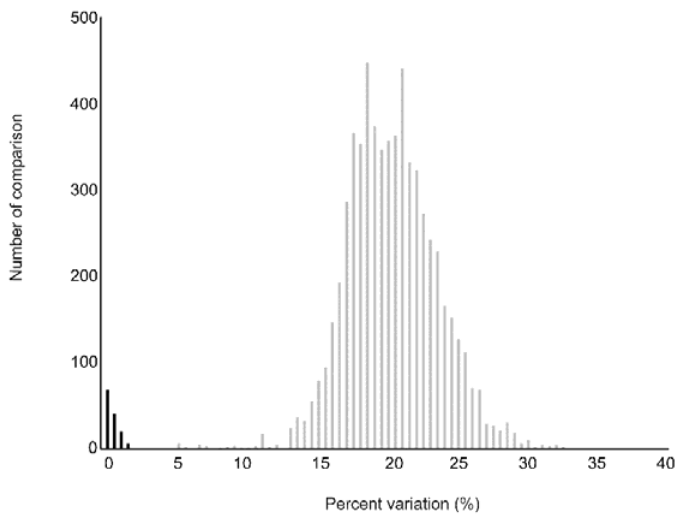
Figure 3. Frequency distribution of intraspecific (black) and interspecific (grey) genetic divergence in the sampled odonates (regional